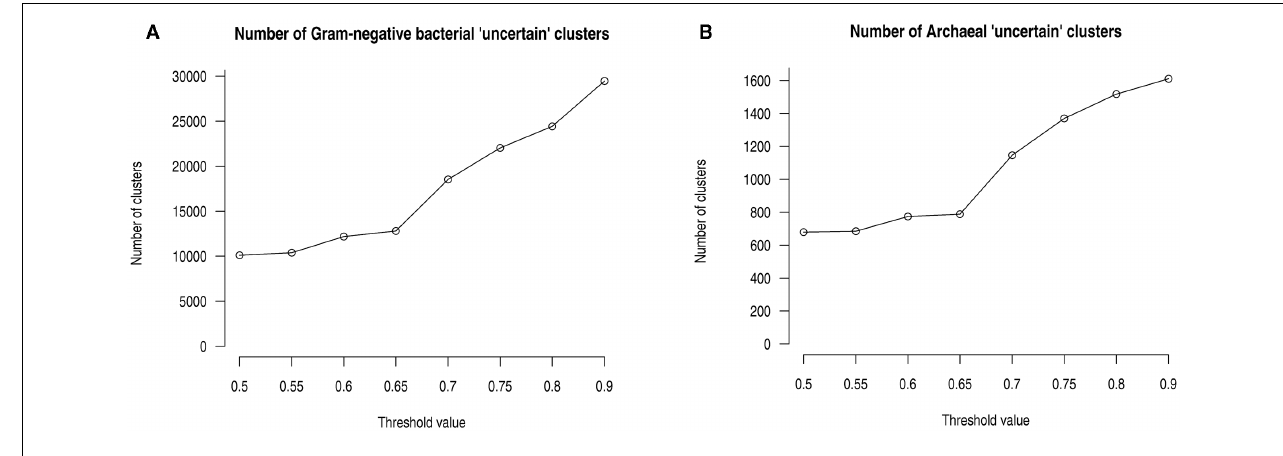
threshold) increases at 0.7 – to minimize the number of “uncertain” clusters, cluster SCLs were assigned when a fraction of 0.7 or above ( = 70%) of the proteins in a cluster are predicted to have a given